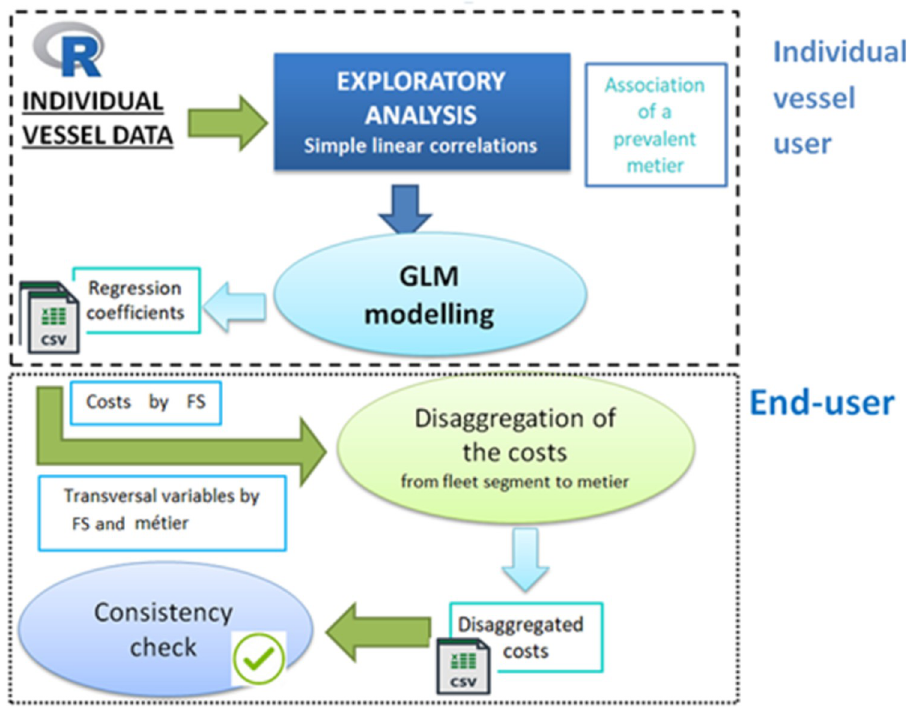
Fig 1. Workflow summarizing the functioning of the SECFISH